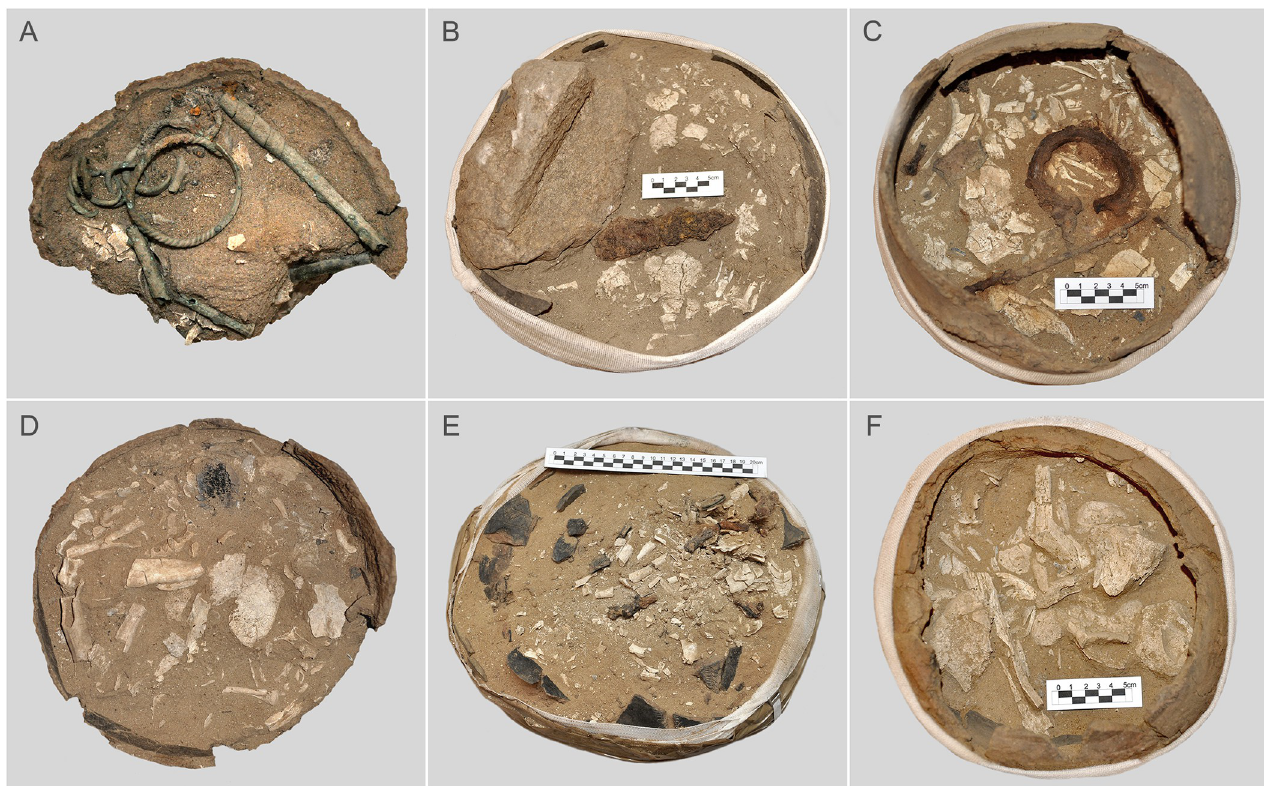
Fig 2. Various forms of depositing burnt human remains and grave goods consisting of metal artefacts. Metal items covering the burnt bones in the urn from burial 506 (A), 544 (B), 578 (C), the bones of the skull vault located in the top layer of the urn from grave 537 (D), and fragments of the shafts and epiphyses of long bones located in the upper-most layers of the urns from graves 858 (E) and 722